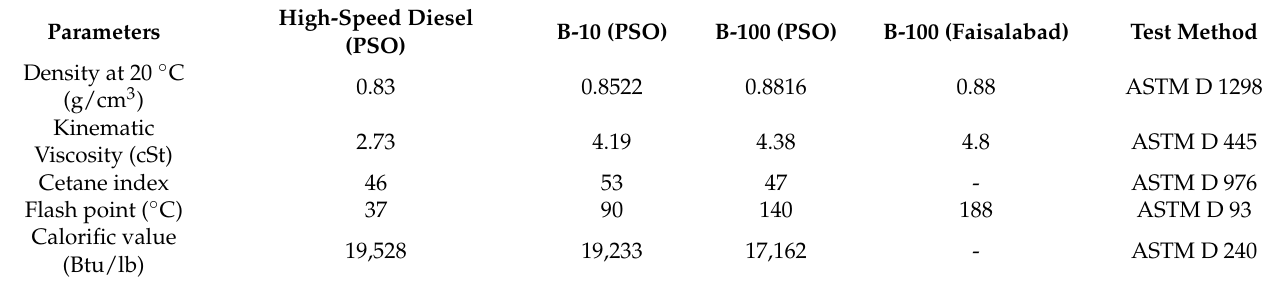
Table 4. Tested by Faisalabad [126] and PSO [29], domestic biodiesel’s important characteristics from Jatropha and high- speed